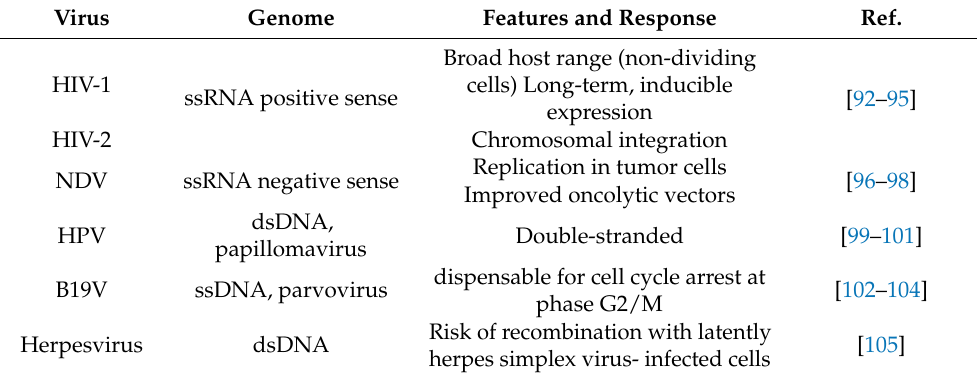
Table 1. RNA and DNA species present in smart nanoexosomes derived from virus-infected cells. Virus Genome Features and Response